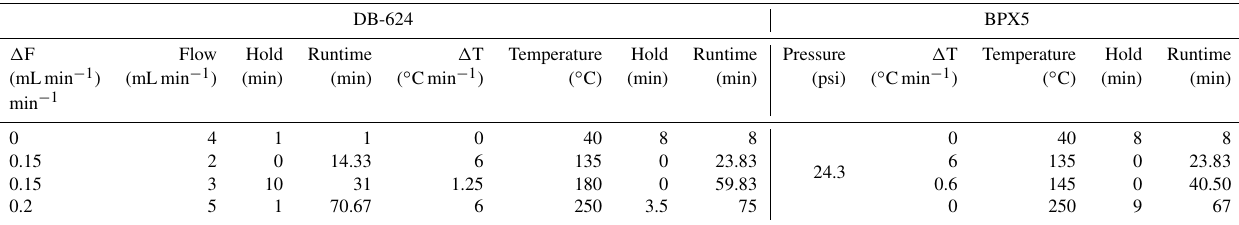
Table 3. Chromatographic details for the BPX5 and DB-624 columns. DB-624 BPX5 (cid:49)